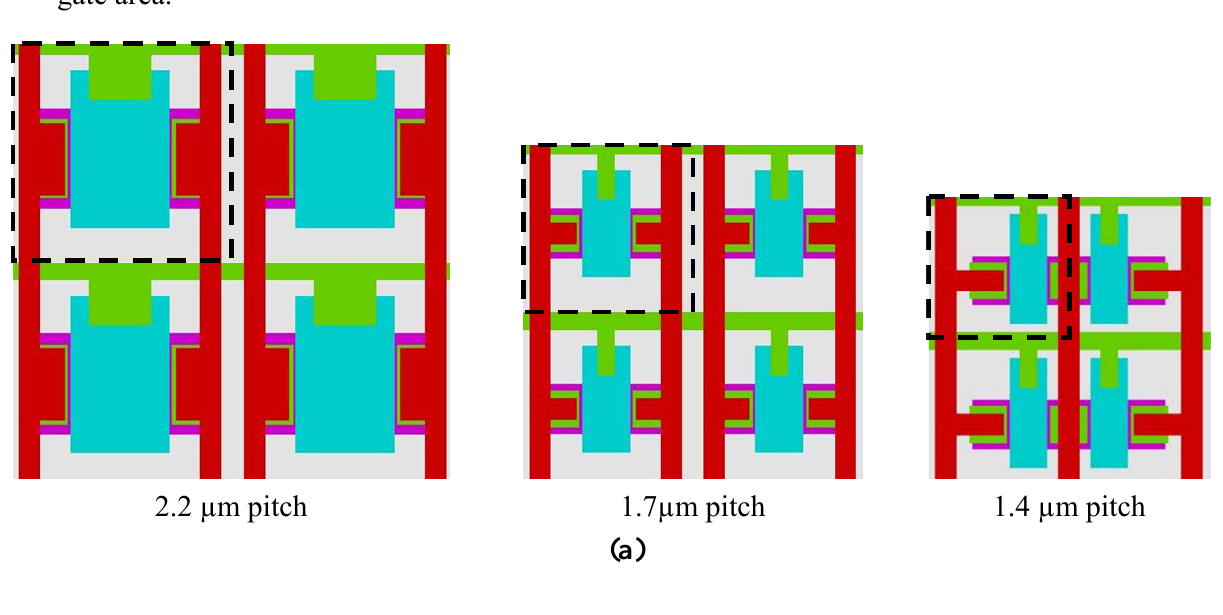
Figure 6. (a) Layout of three pixels in different sizes: 2.2 µm pitch, 1.7 µm pitch and 1.4 µm pitch. (b) Simulated structures of the three pixels. (c) Conversion gain against effective gate